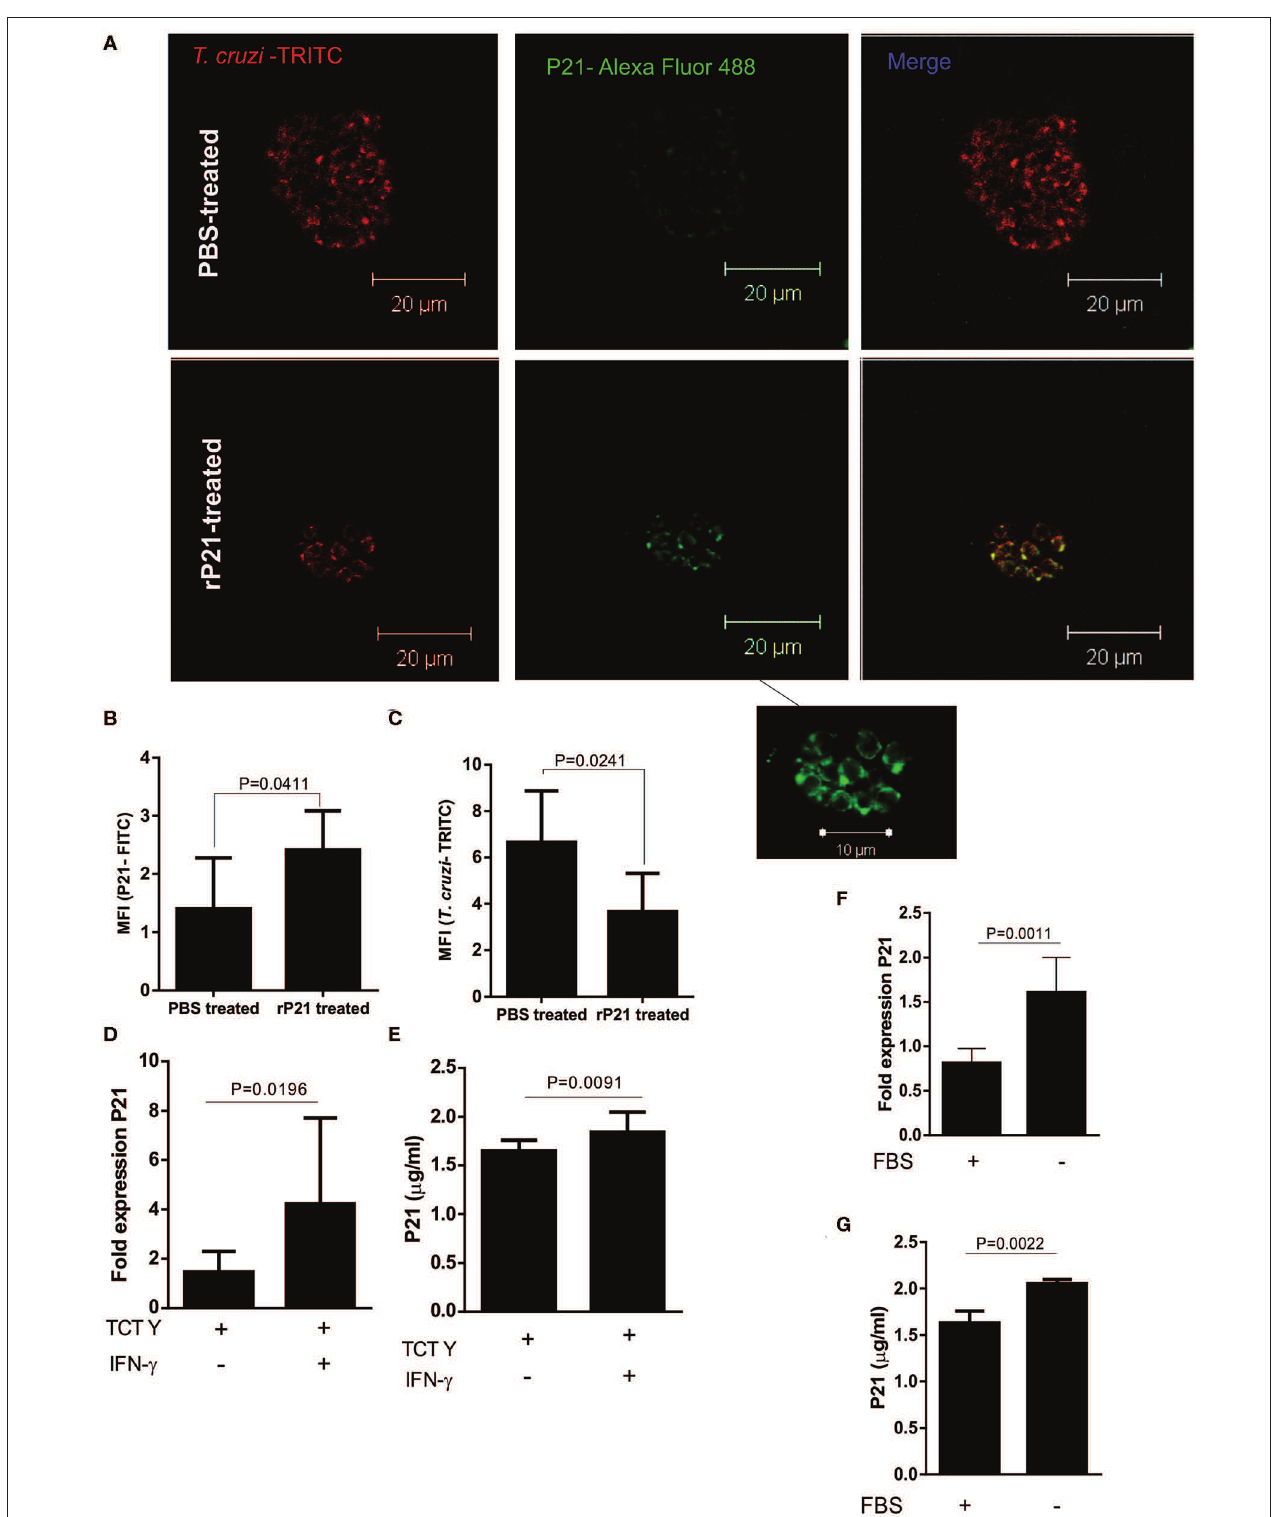
FIGURE 7 | rP21 as a soluble factor acts as an inducer of T. cruzi dormancy. (A) Amastigotes from cardiac nests qualitatively produced more native P21 when mice received treatment with the recombinant protein. (B) P21 quantification shows a higher presence of this protein in amastigote nests of mice treated with